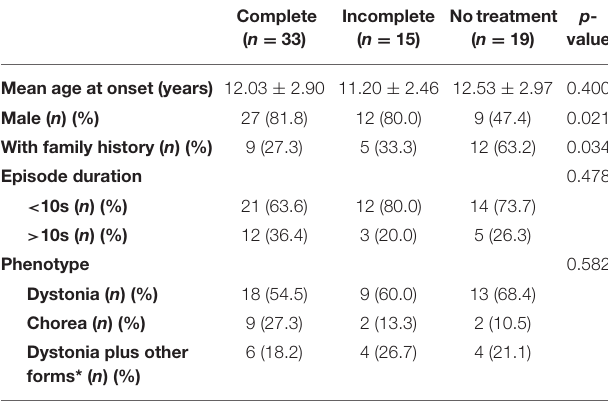
TABLE 1 | Clinical features in male and female cases. TABLE 2 | Differences between in different drug reactivity